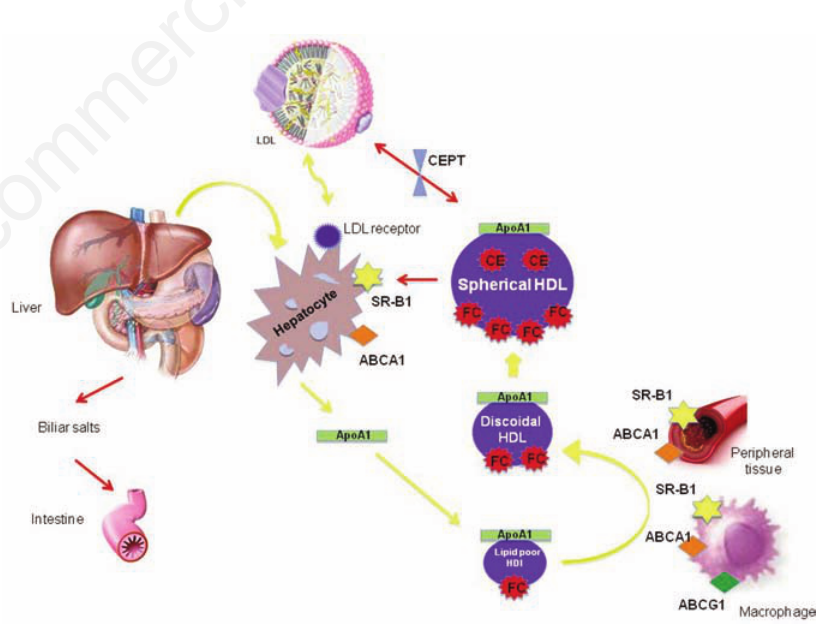
Figure 2. Schematic view of reverse cholesterol transport. Apia-I is responsible for the metabolic fate of high-density lipoprotein (HDL) cholesterol HDLs and it is synthesized by the liver. HDLs are released to the circulation as a lipid-poor HDL (nascent HDL), mostly formed by Apia-I and phospholipids (PL). Through their metabolic maturation, HDLs interact with the ABCA1, ABCG1 and also SR-B1 receptor in the macrophage sur- face and peripheral tissue increasing their lipid content by taking PLs and cholesterol becoming spherical HDL. The cholesterol of the HDLs is transported to the liver, via the scavenger receptor class B, type I (SR-BI), for further metabolization and excretion to the intestines in the form of bile acids and cholesterol, completing the process of reverse cho- lesterol